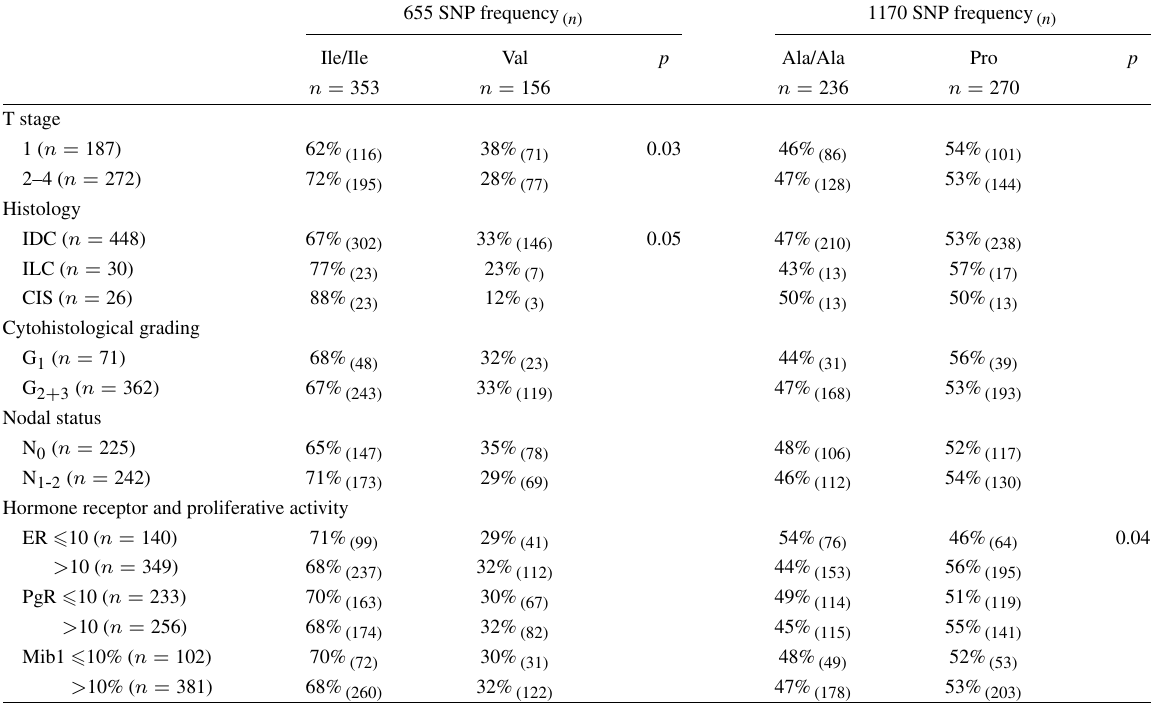
Clinical-pathological features of 655Val carriers and 1170Pro